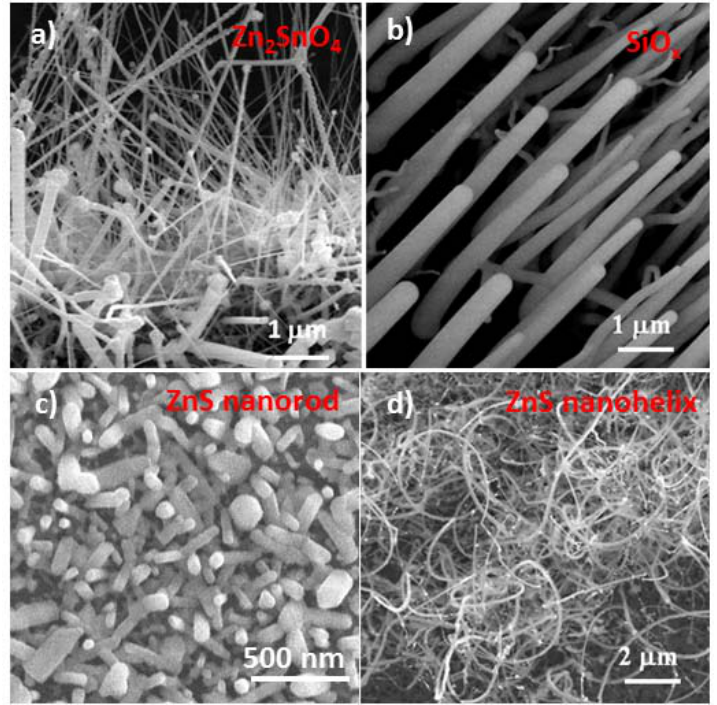
Figure 2. A set of SEM images displaying the nanostructure templates fabricated by vapor phase process ( a ) Zn SnO nanowire arrays, ( b ) SiO 2 4 and ( d ) ZnS helical nanostructures.